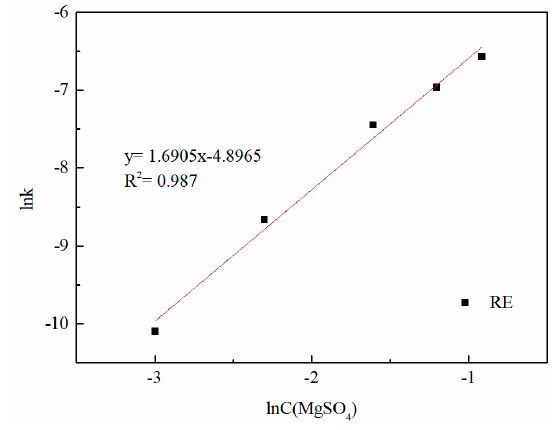
Figure 9. Plot of lnk as a function of magnesium sulfate concentration.